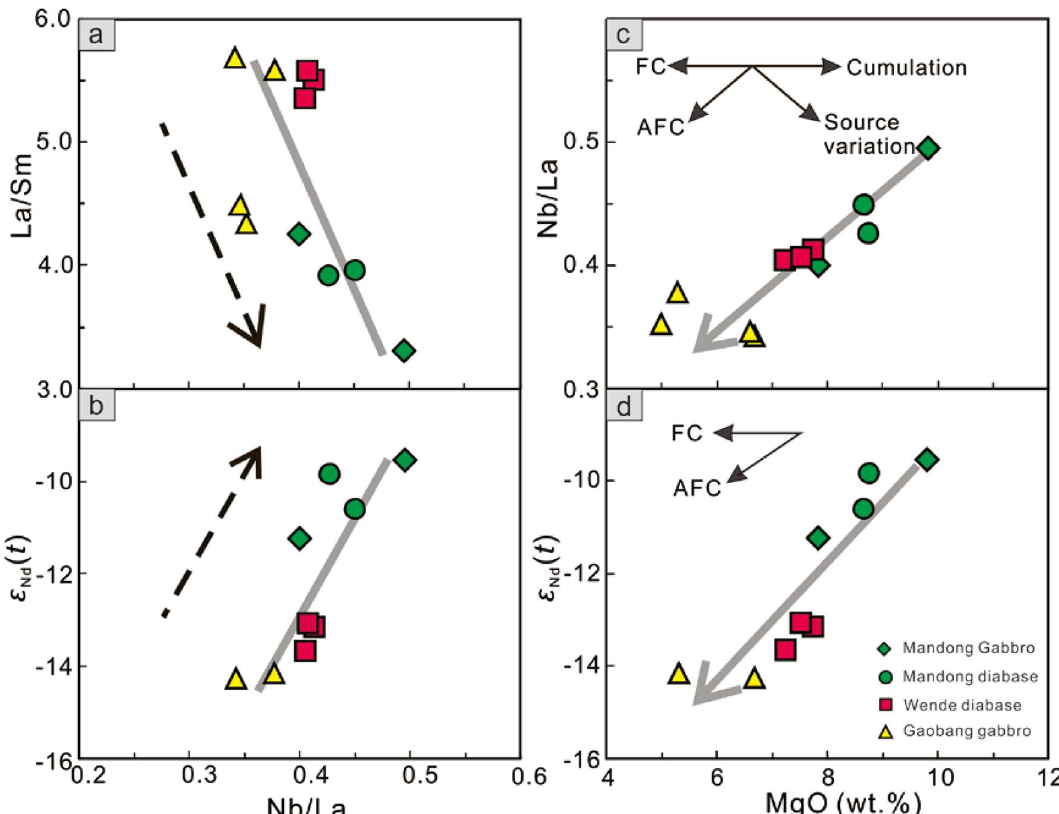
Figure 7. Plots of La/Sm and ε Nd ( t ) versus Nb/La ( a , b ), and Nb/La and ε Nd ( t ) versus MgO ( c , d